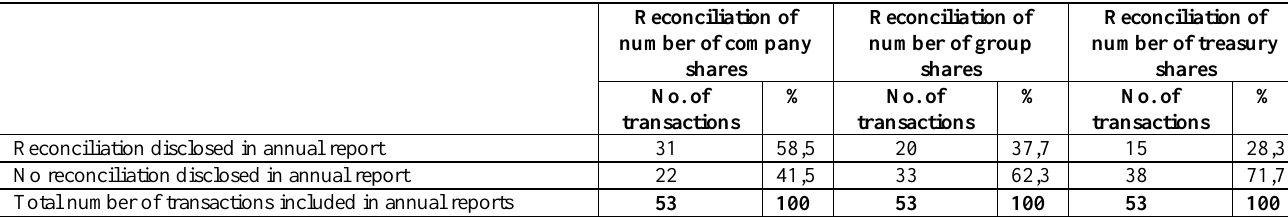
Table 3: Disclosure in annual report on reconciliation of movement of number of shares in issue